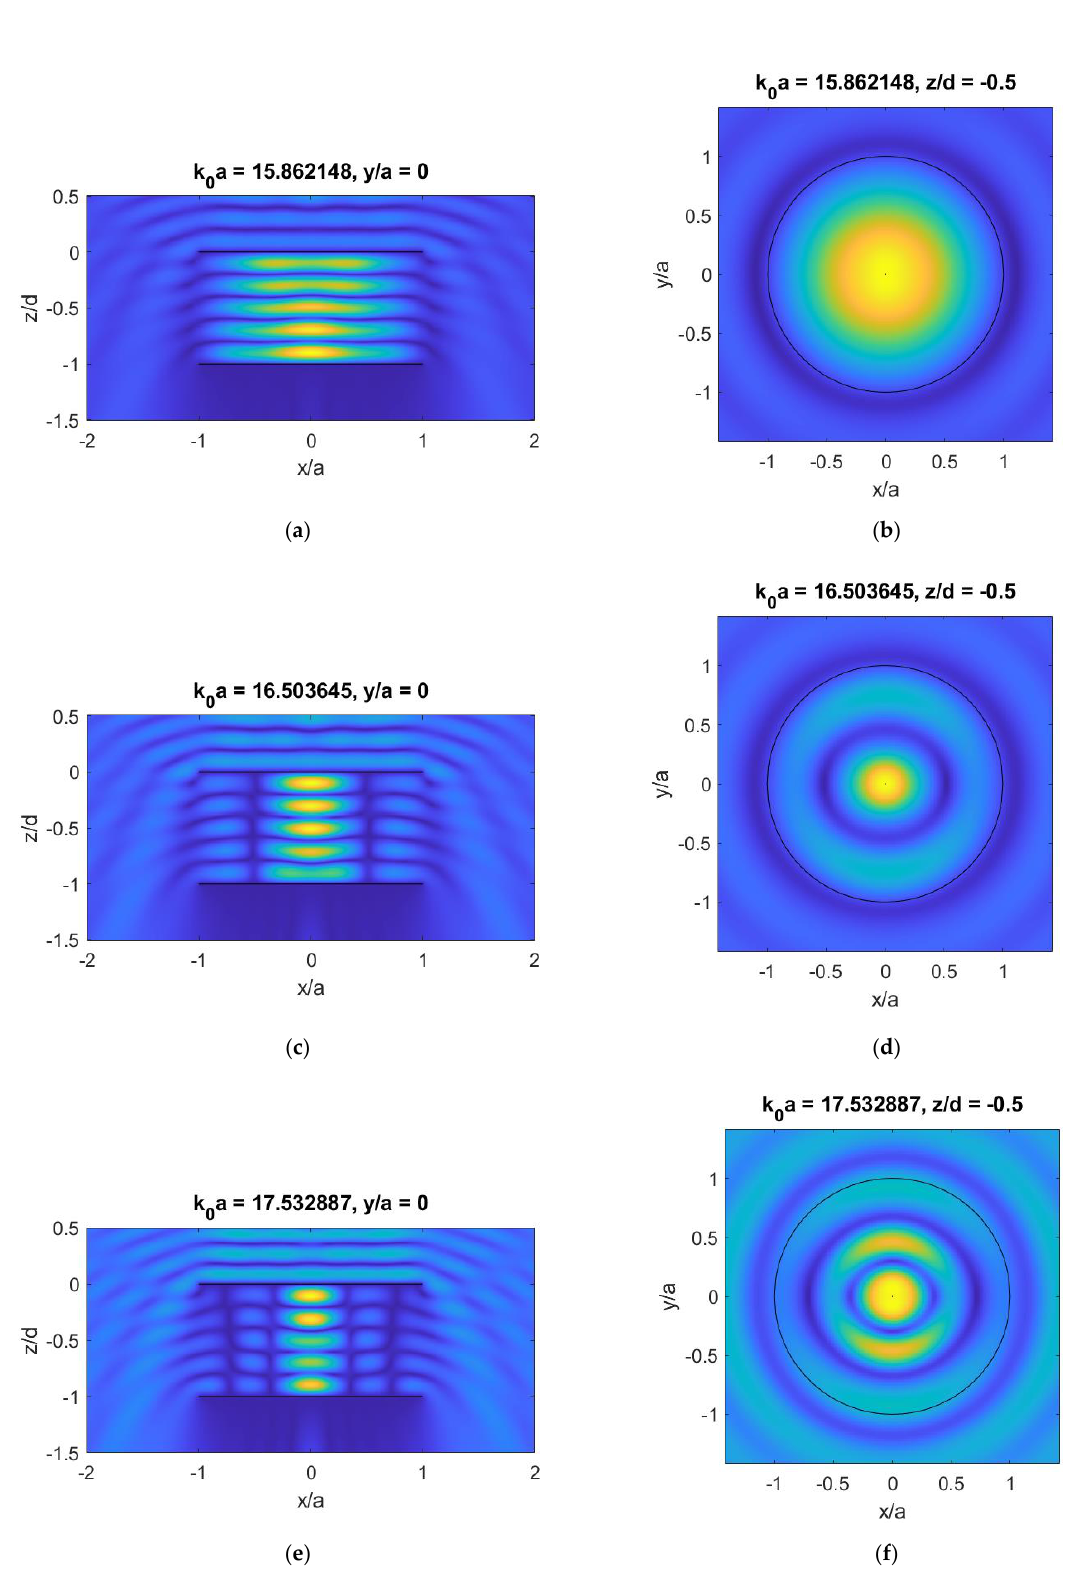
Figure 8. Near E-field behavior in the Cartesian coordinate planes xz and xy of a two stacked thin resistive disks resonator at three resonance frequencies ( k 0 a = 15.862148,16.503645,17.532887), when a plane wave orthogonally impinges onto the structure with E 0 = E 0 ˆ y : ( a ) Near E-field in the xz plane, k 0 a = 15.862148; ( b ) Near E-field in the xy plane, k 0 a = 15.862148; ( c ) Near E-field in the xz plane, k 0 a = 16.503645; ( d ) Near E-field in the xy plane, k 0 a = 16.503645; ( e ) Near E-field in the xz plane, k 0 a = 17.532887; ( f ) Near E-field in the xy plane, k 0 a =